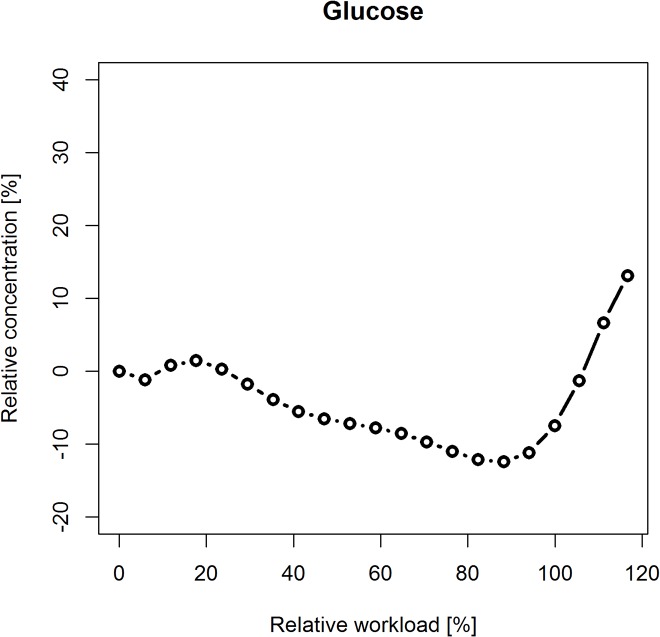
Kinetic signature of glucose.A delayed response pattern is apparent in glucose, decreasing in relative concentration (-12%) towards the end of exercise with a steep increase (up to 13%) after the end of exercise during the recovery phase.